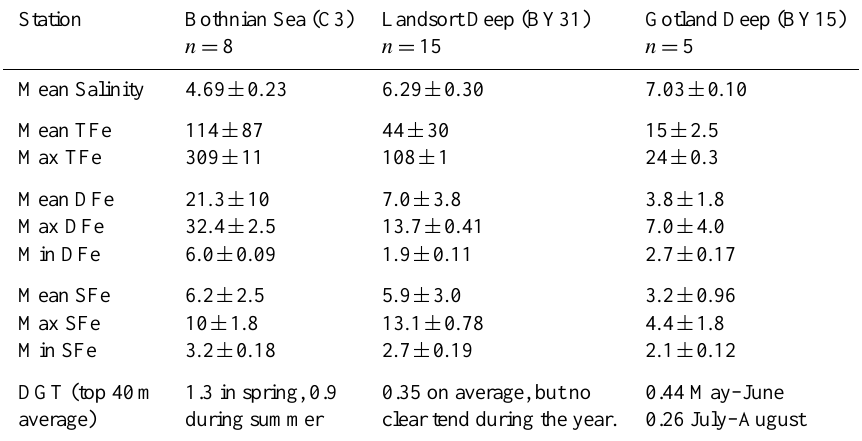
Table 1. Iron concentration at 5m depth in different fractions at the three studied stations in the Baltic Sea. All Fe concentrations are given in nM. The ± notation indicate the standard deviation for mean values, for max and minimum values, ± indicate the precision of the measurement.